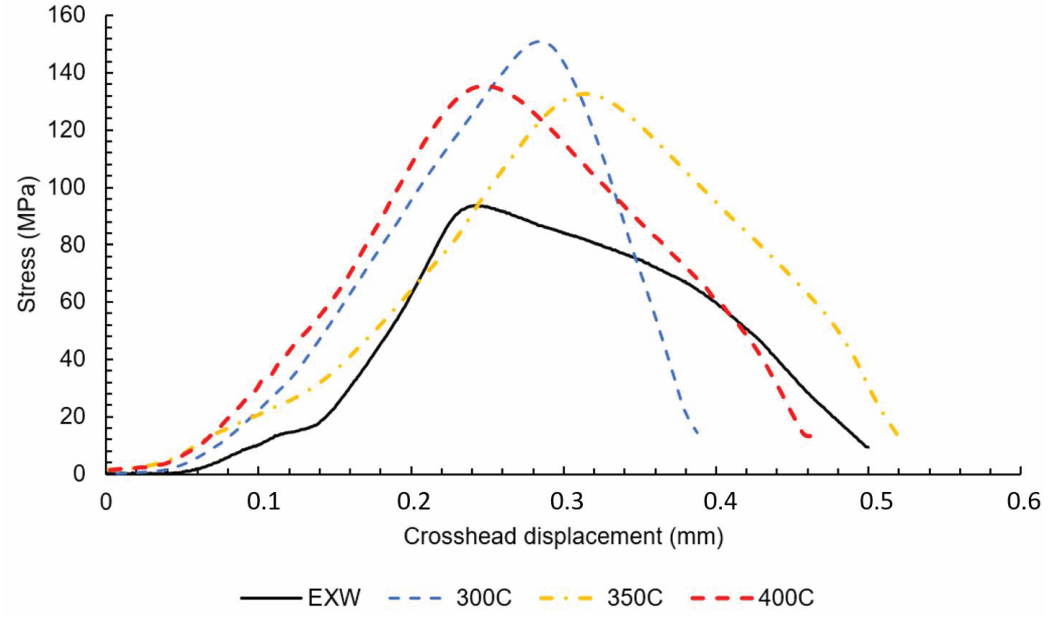
Figure 6. The tensile curves for Al / Ti interface in the as-welded state (EXW) and after hot-rolling (300C, 350C, 400C). Table 3. Tensile tests results with standard